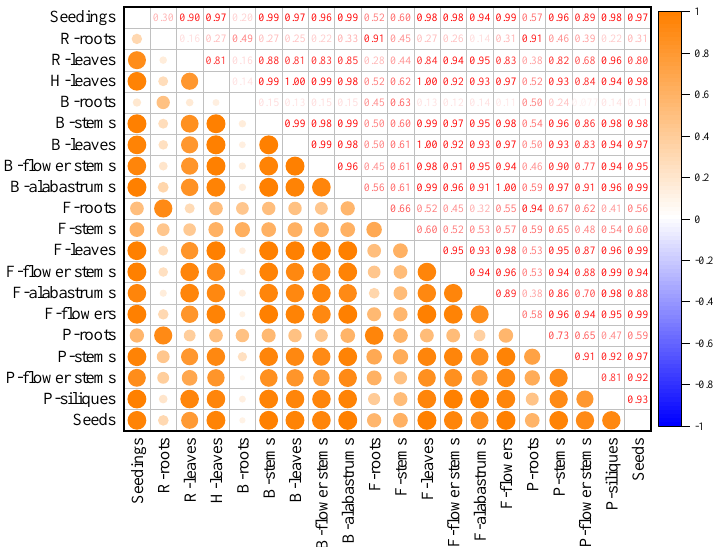
Figure 9. Correlation analysis of different parts in different growth stages of mustard resource JC 18-56. (R: rosetting phase; H: harvesting phase; B: bolting phase; F: flowering phase; P: pod − setting phase). The orange color in the graph represents positive correlation, and the blue color represents negative correlation. The color is darker, the correlation is stronger.